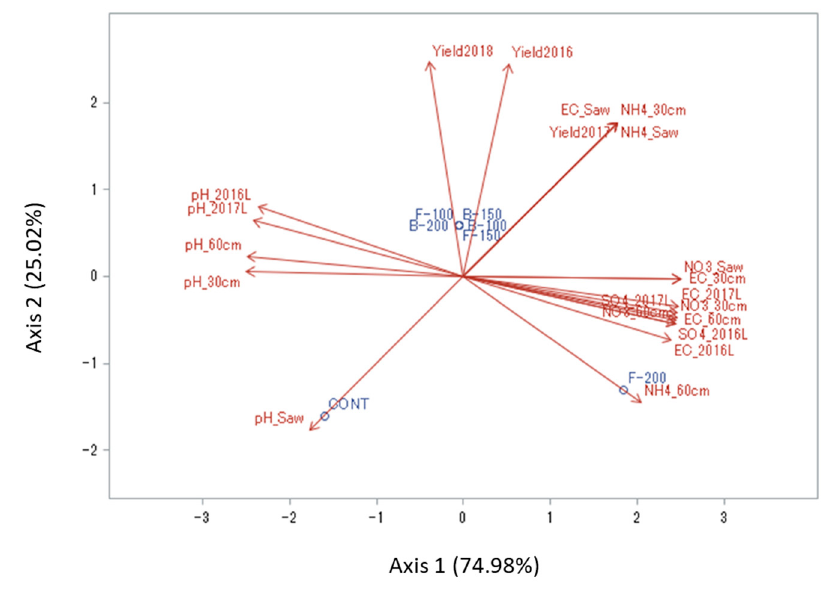
Figure 7. Correlations between berry yield and soil and leachate chemical properties as tested by principal component analysis (PCA) (Yield2016, Yield2017, Yield2018, blueberry yield in 2016, 2017 and 2018, respectively; NO3_Saw, NO3_30 cm, NO3_60 cm, soil nitrate N concentrations in the sawdust layer and 0–30 cm and 30–60 cm depth; NH4_Saw, NH4_30 cm, NH4_60 cm, soil ammonium N concentrations in the sawdust layer and 0–30 cm and 30–60 cm depth; pH_Saw, pH_30 cm pH_60 cm, soil pH in the sawdust layer and 0–30 cm and 30–60 cm depth; EC_Saw, EC_30 cm, EC_60 cm, electrical conductivity in the sawdust layer and 0–30 cm and 30–60 cm depth; EC_2016L, EC_2017 L,